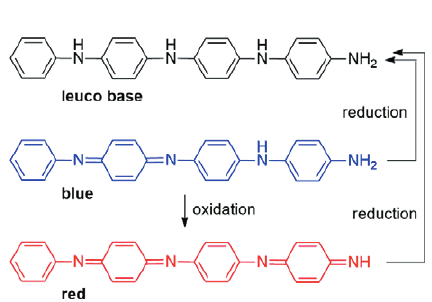
Figure 9. Structures and interconversions of isolated